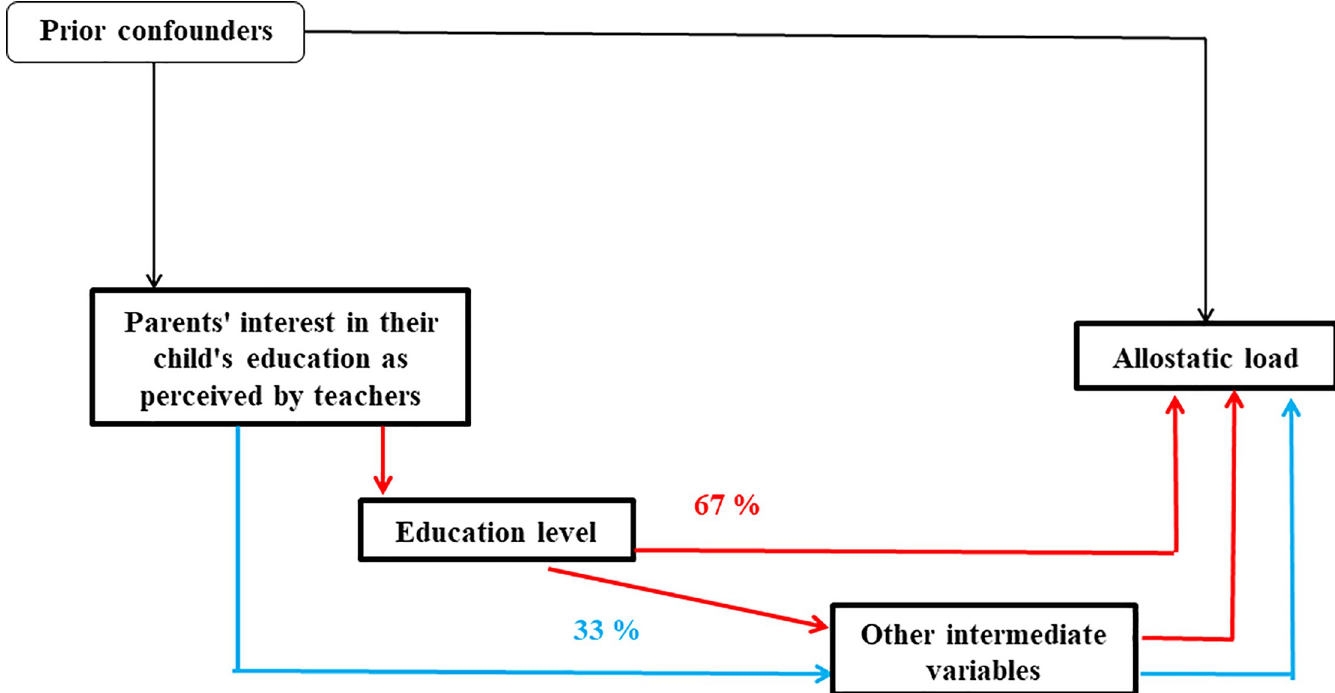
Fig 2. Direct and indirect effect results between parental interest and allostatic load obtained from multiple imputation for men (n = 4057).